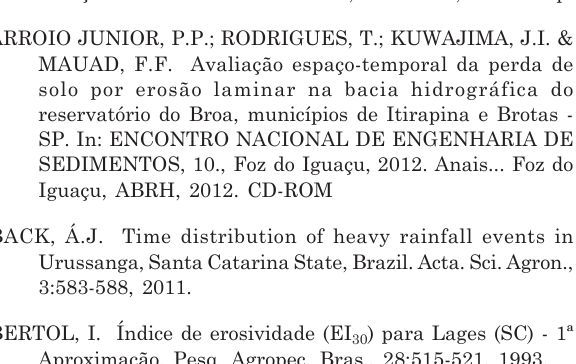
Figura 3. Curvas de ajuste entre o índice de erosividade (EI 30 ) médio mensal e o coeficiente de chuva (Rc) para Urussanga,